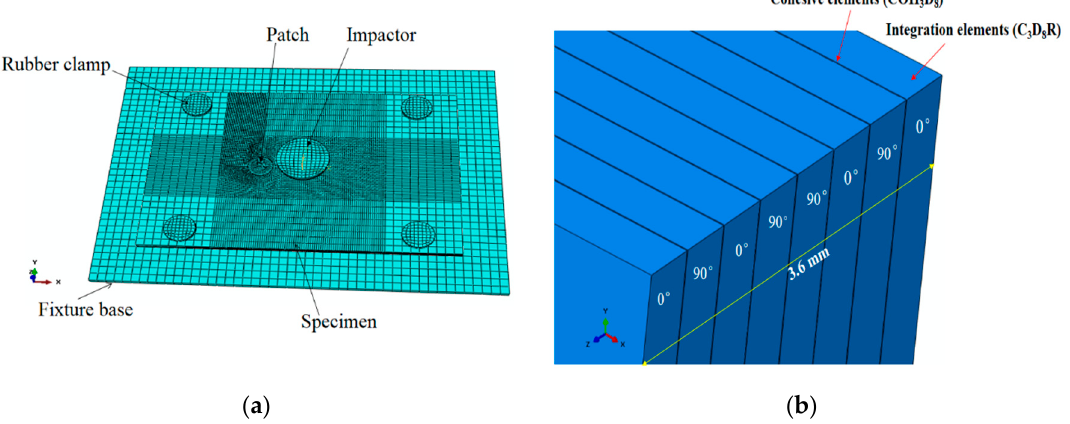
Figure 6. Diagram of the FE model for the LVI test: ( a ) specimen repaired containing a circular patch and ( b ) the layup of the CFRP laminate.